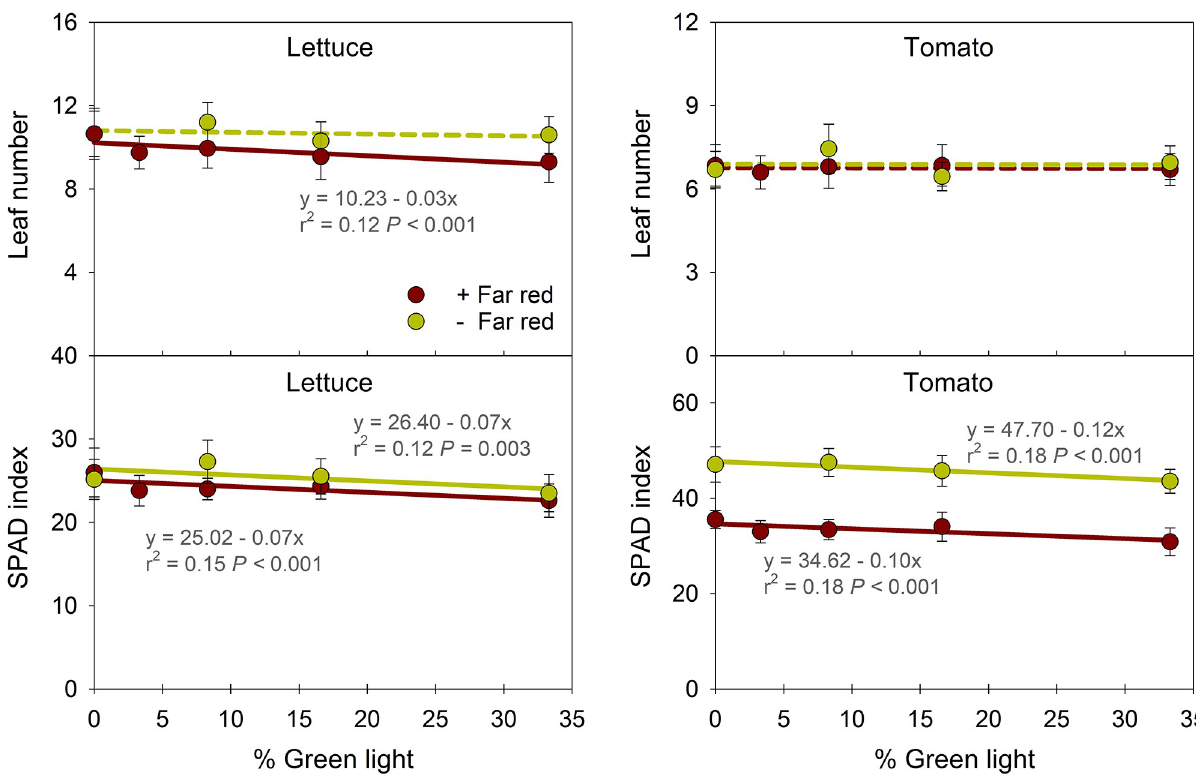
Fig 3. Influence of percentage of green light on leaf number and SPAD index of lettuce ‘Cherokee’ and tomato ‘Bamborange’ with (+) and without (-) far-red light. See Fig 1 and Table 1 for information on the lighting treatments. Each data point represents the mean and standard deviation of two replications with 10 subsamples (plants) per replication and species (n = 20). Regression equations, r 2 values, and P values are presented when statistically significant (solid line) but not when non-significant (dashed